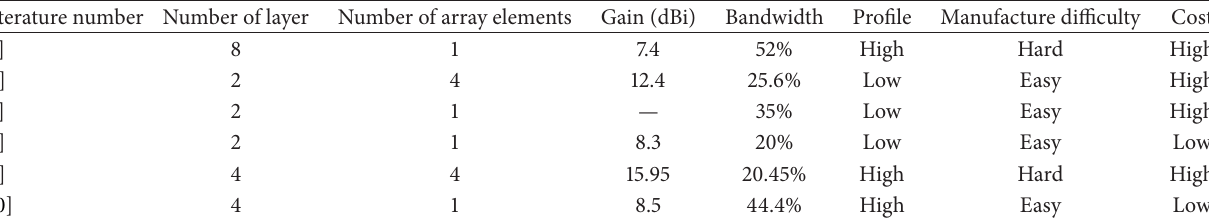
Table 1: Detailed data of the antennas mentioned